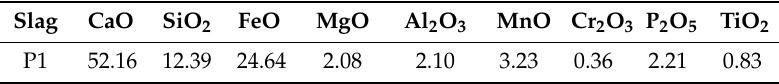
Table 1. Chemical analysis of investigated industrial slag